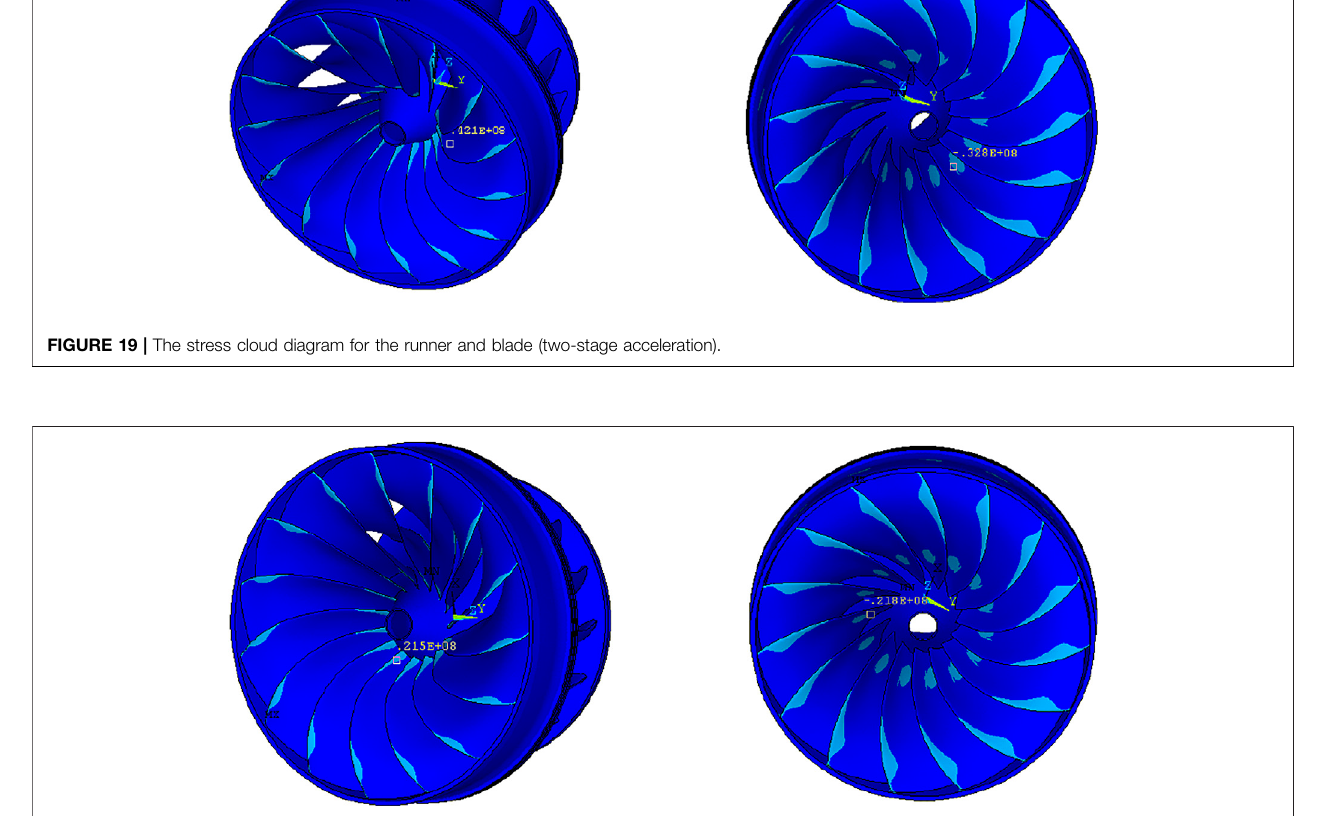
FIGURE 20 | The stress cloud diagram for the runner and blade (optimized control mode).